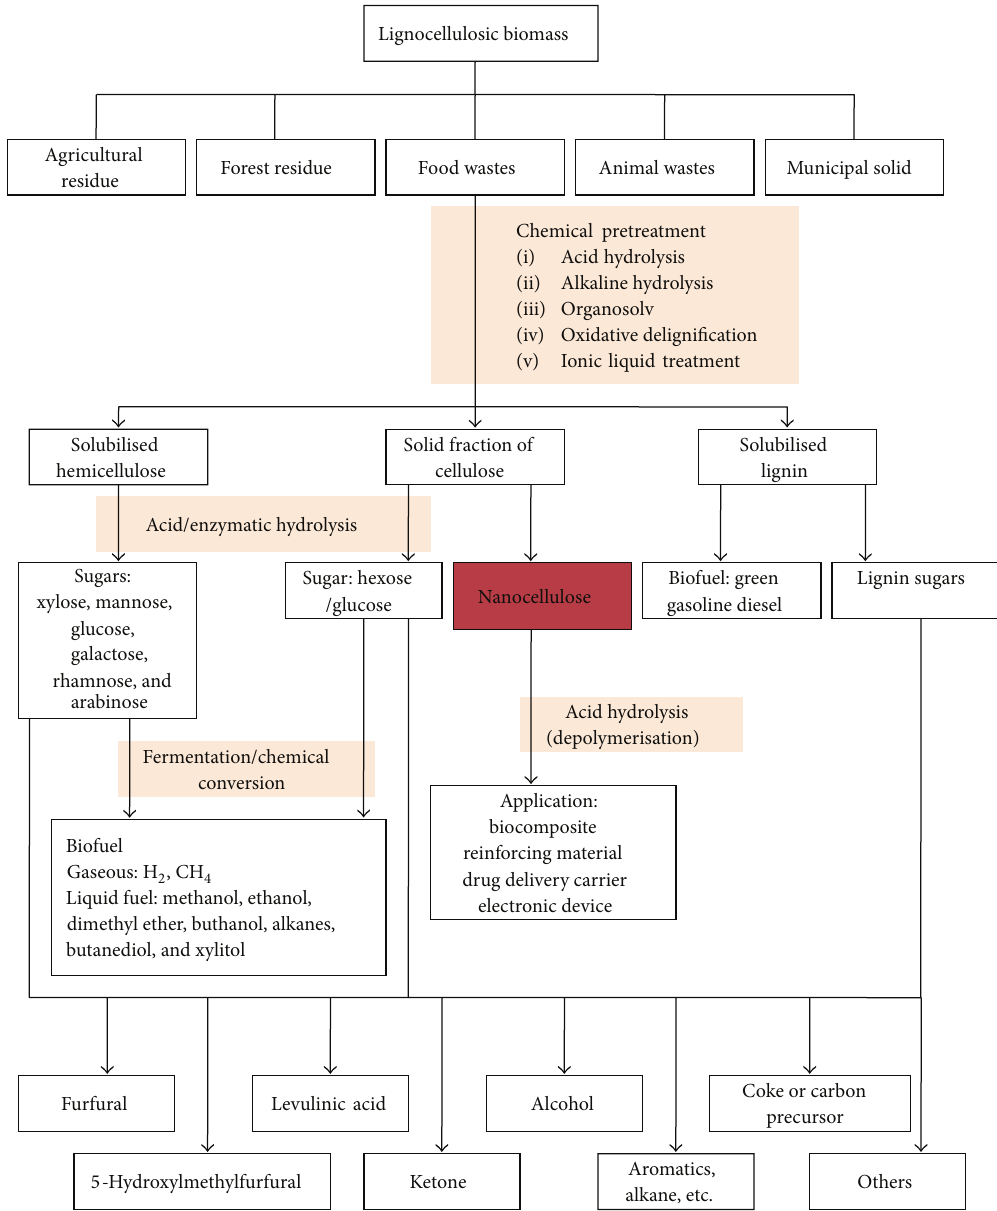
Figure 1: Roadmap of lignocellulosic biomass biorefinery to nanocellulose intermediate and chemicals.